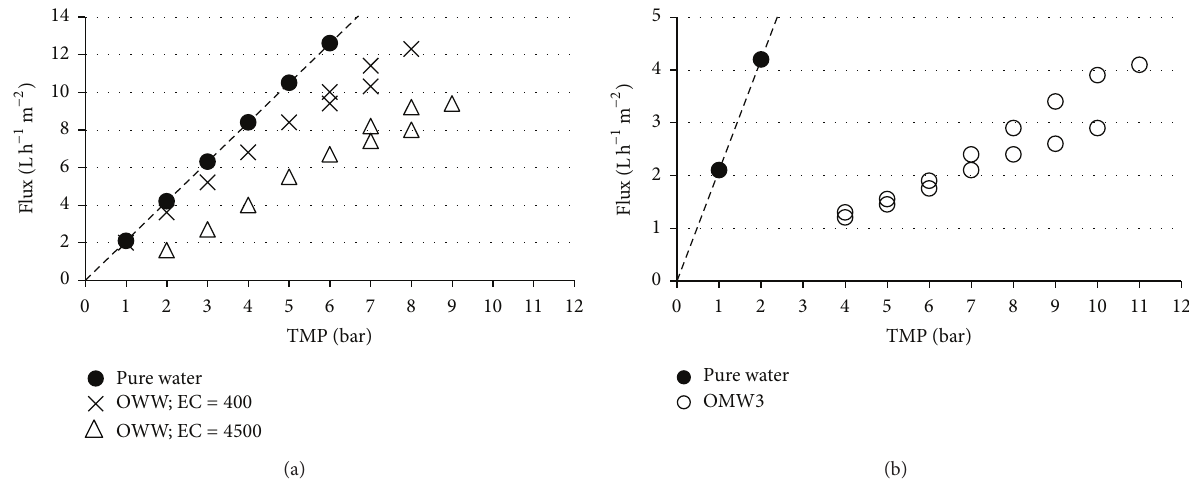
Figure 3: Comparison of the boundary flux measurement patterns found on NF for OWW (a) and OMW3 (b).